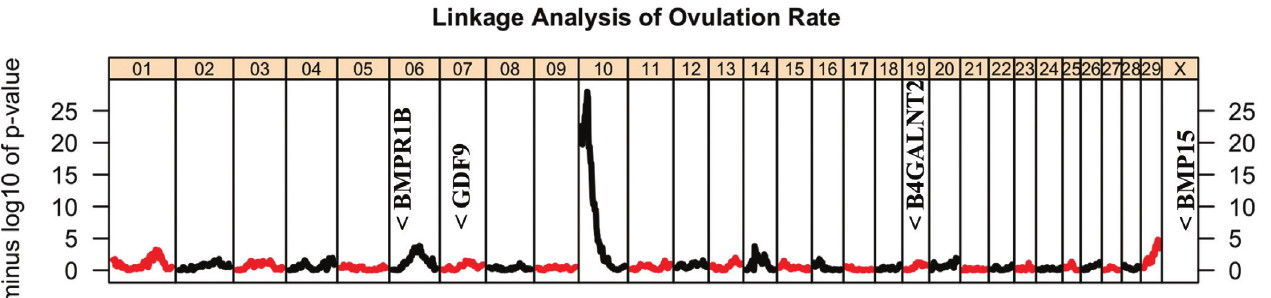
Fig 2. Within half-sib family linkage analysis for ovulation rate. Minus log 10 of the p-value from the test of association of paternally inherited haplotype with ovulation rate is shown on the y-axis and the x-axis corresponds to marker location. Each vertical panel corresponds to one chromosome. Approximate locations of known major genes for ovulation rate in sheep are indicated.